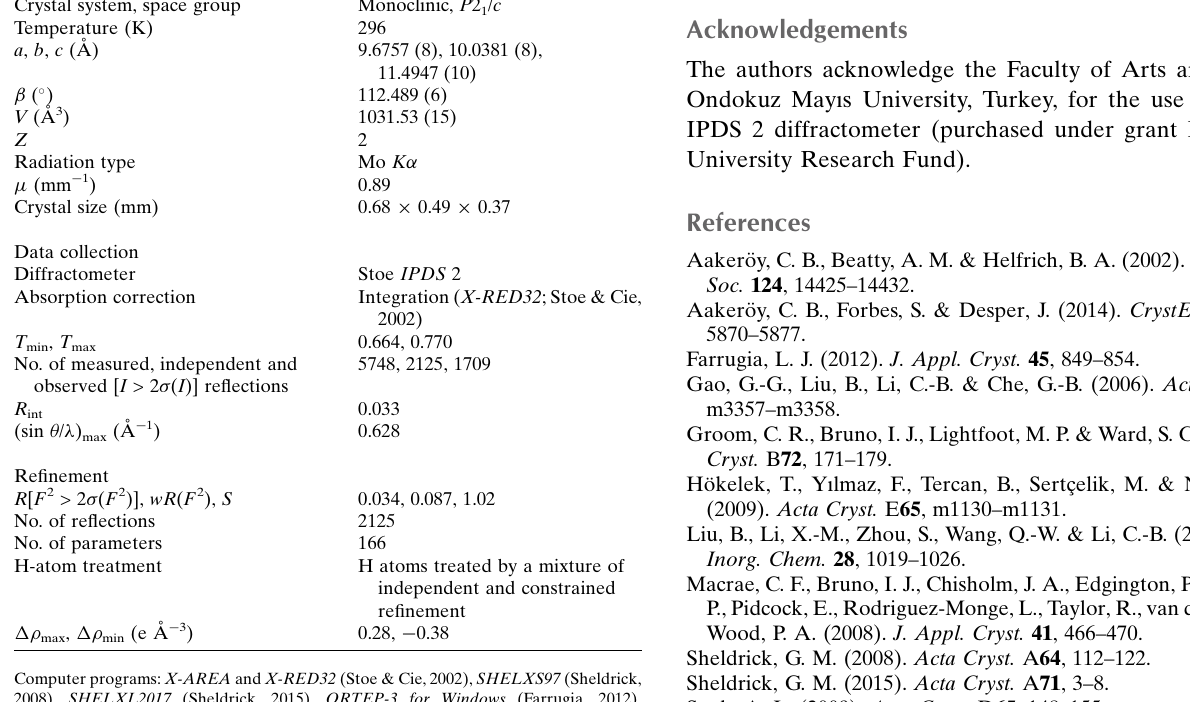
Table 3 Experimental details. Crystal data Chemical